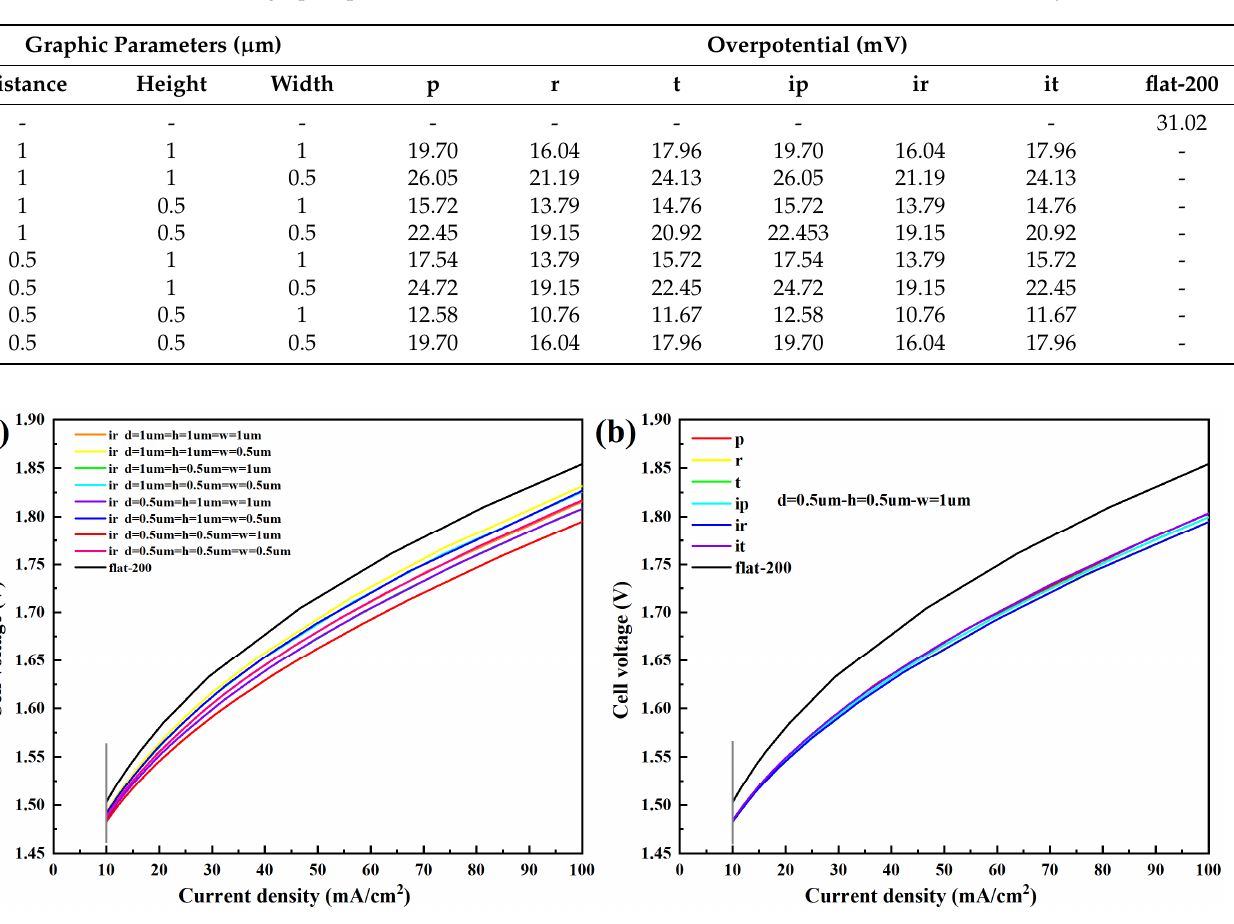
Figure 8. The polarization curves of the micro ‐ nano surface and vertical flat electrodes. ( a ) The polarization curves of ir with different graphic parameters; ( b ) The polarization curves of six structures at the graphic parameters of 0.5 μ m, 0.5 μ m, and 1 μ m. Table 3. The total length of micro ‐ nano structural units and overpotential of each micro ‐ nano sur ‐ face electrode.